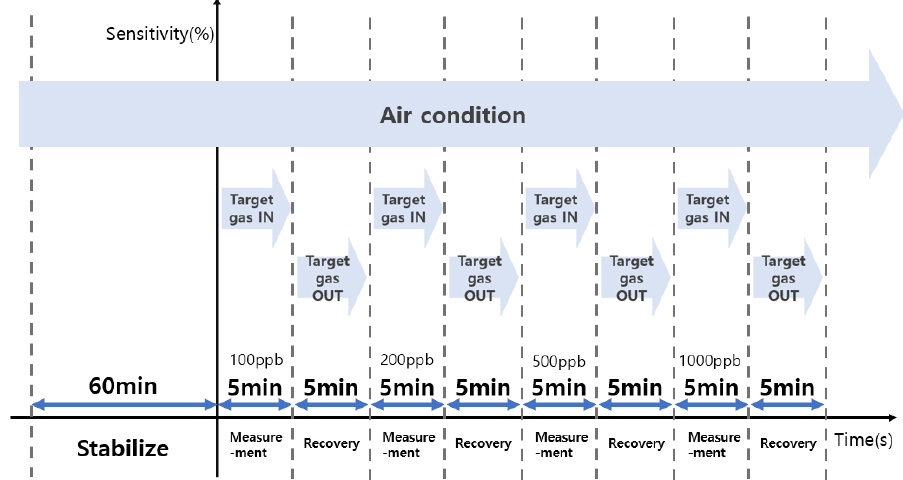
Figure 4. Process for determining the sensing characteristics at ppb levels of the target gas.